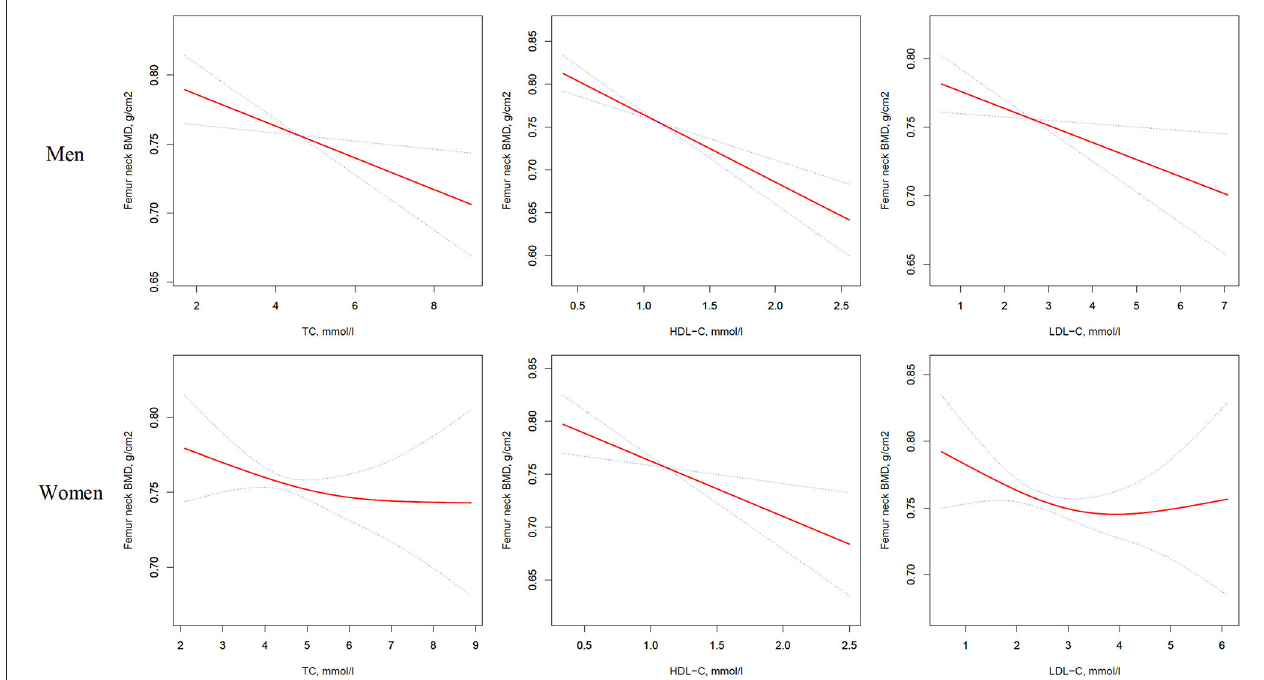
FIGURE 2 | Multivariate adjusted smoothing spline plots of femur neck BMD by TC, HDL-C, and LDL-C. Red dotted lines represent the spline plots of TC, HDL-C, and LDL-C and blue dotted lines represent the 95% CIs of the spline plots. Adjusted for age; diabetic duration(y); treatment of DM; smoking; drinking; BMI; cerebrovascular disease; kidney disease; family history of DM; diastolic blood pressure; FBG, unit; Cr, umol/l; BUN, mmol/l; Ca, unit; ALT, U/L; AST, U/L; ALP, U/L.